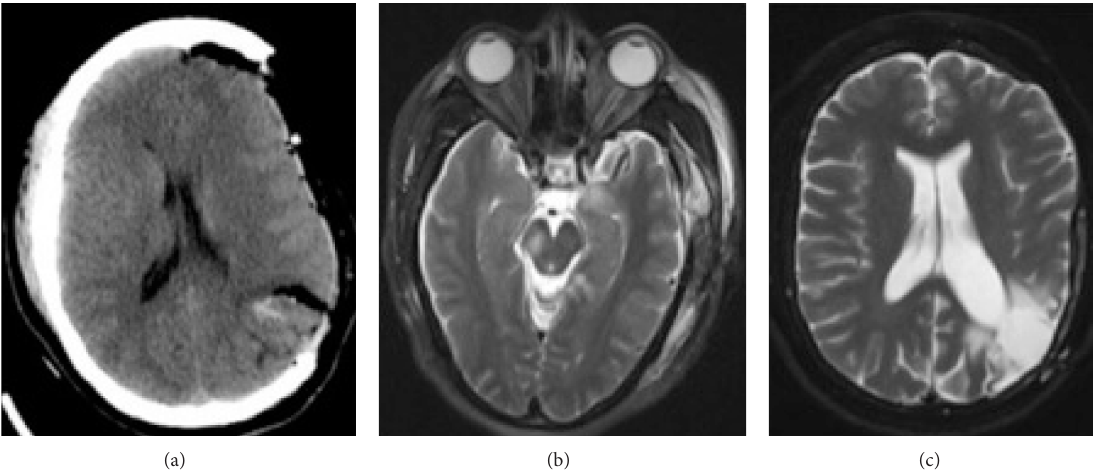
Figure 2: (a) Axial CT status after craniectomy, demonstrating partial clot evacuation and improved midline shift. The AVM is still present with residual hemorrhage; (b) axial T2 MRI postoperative day 2 demonstrating ischemic damage in the left hippocampus and right cerebral peduncle in the area of the corticospinal tract (Kernohan’s Notch); (c) axial T2 MRI demonstrating complete resection of the AVM and